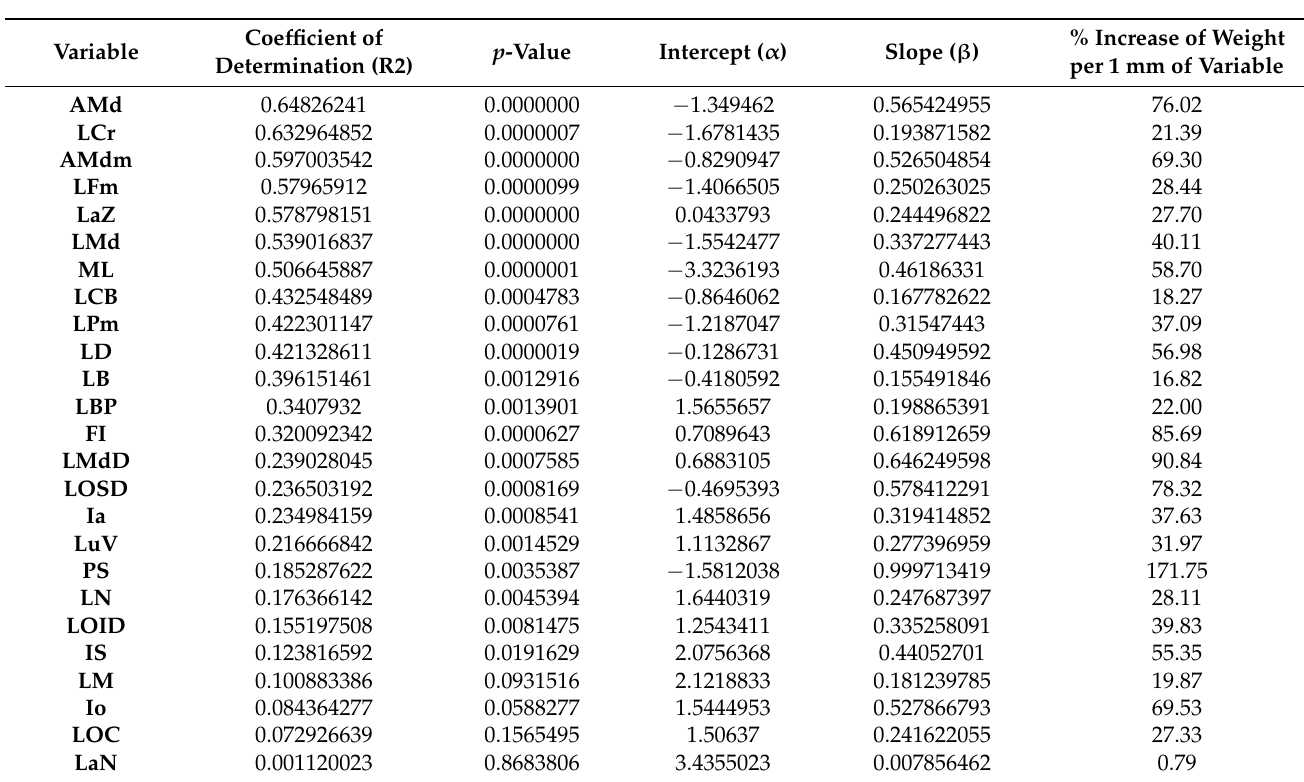
Table 9. Craniological features ordered by ratio of explained variability to the log-transformed weight of Pannonian root vole. To predict weight, use: e α + β * x where x is measured variable